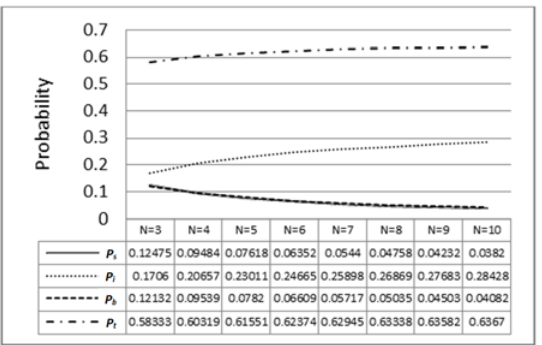
Figure 8: Queue threshold (N) and the variation of probability in each state